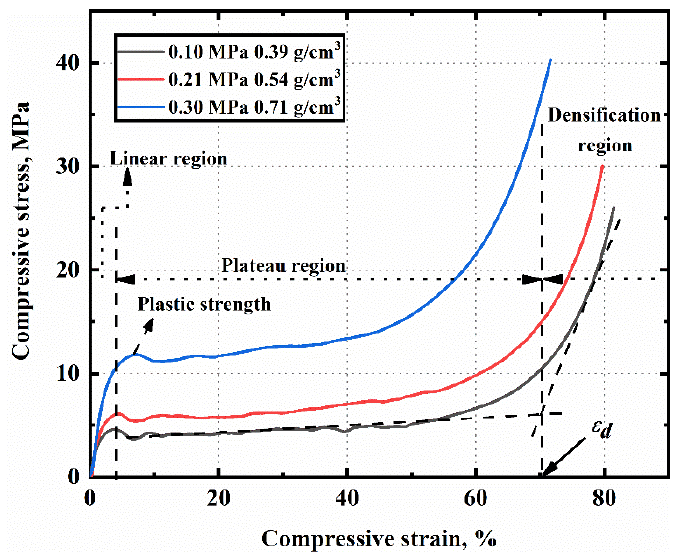
Figure 3. Typical compression stress-strain curves of aluminum foams.